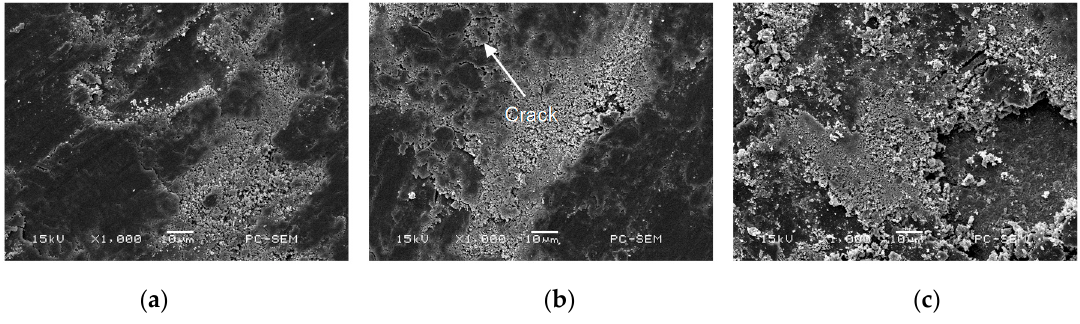
Figure 20. Morphologies of worn track on 20% Cr–80% Ni coating. ( a ) Adhesive wear; ( b ) Crack; ( c ) Spalling off.